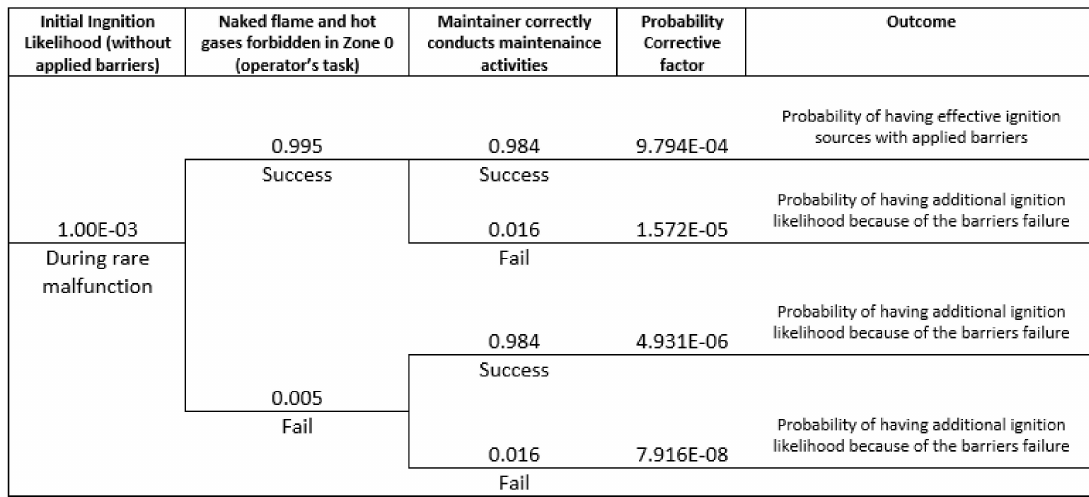
Figure 5. Fault tree assessment of the ignition source probability corrective factor in case of hot